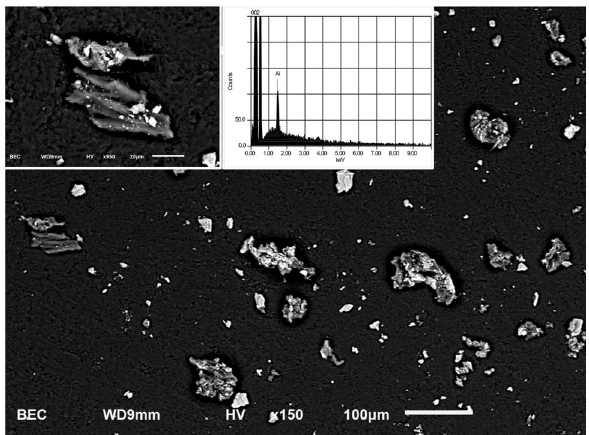
Figure 1. Scanning electron microscope images and energy dispersive x-ray spectrum of counter dust collected by area sampling. Brightness in these backscattered electron images is dependent on atomic number. Particles are of a range of sizes and shapes consistent with grinding/sanding operations and show a mix of bright smaller particles and larger less bright fragments. Left inset shows detailed morphology of selected larger fragments. Right inset shows a spectrum typical of the brighter particles, confirming aluminium as the major detectable element. No elements other than carbon and oxygen are detectable in the less bright phase particles. Magnification scale markers indicate 100 µm and 20